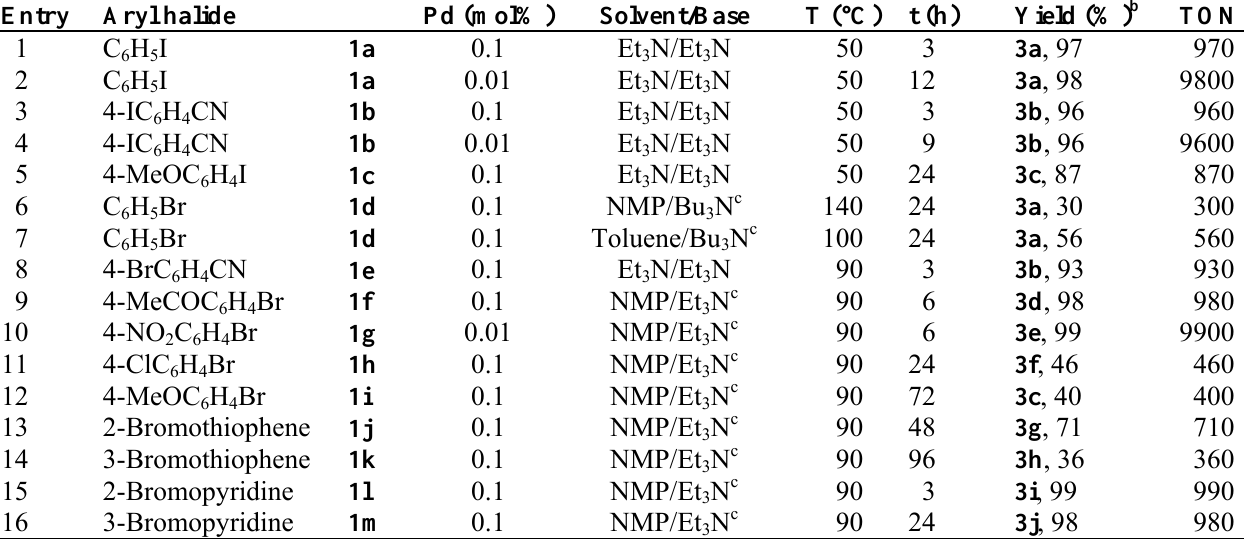
Table 2. Sonogashira reaction of aryl halides ( 1 ) with phenylacetylene ( 2a ) catalyzed by nanosized MCM-41-Pd.